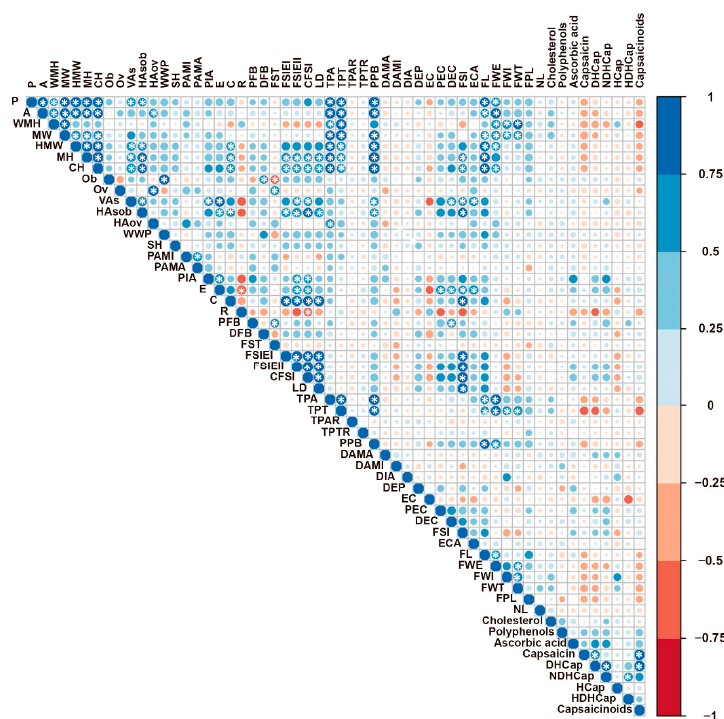
Figure 3. Pearson’s rank correlation coefficients between pairs of traits. Color intensity (right scale) and the size of the circles are proportional to the correlation coefficients. Significant correlations at p < 0.05 are indicated with a white asterisk inside the circle.